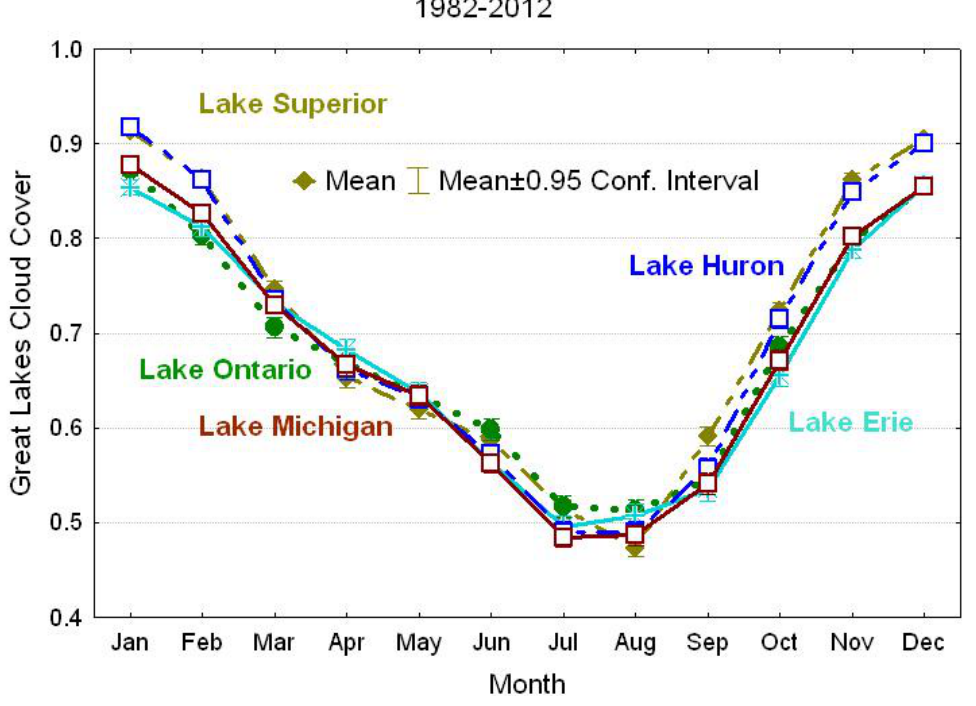
Figure 5. The mean cloud cover as a function of month for each of the Great Lakes. The point represents the mean and the whiskers the 95% confidence interval of the location of the